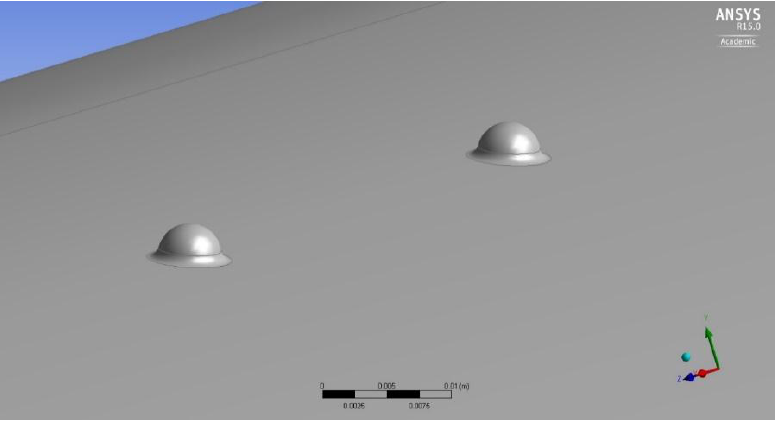
Figure 2. Illustration of the bumps on blade surface.